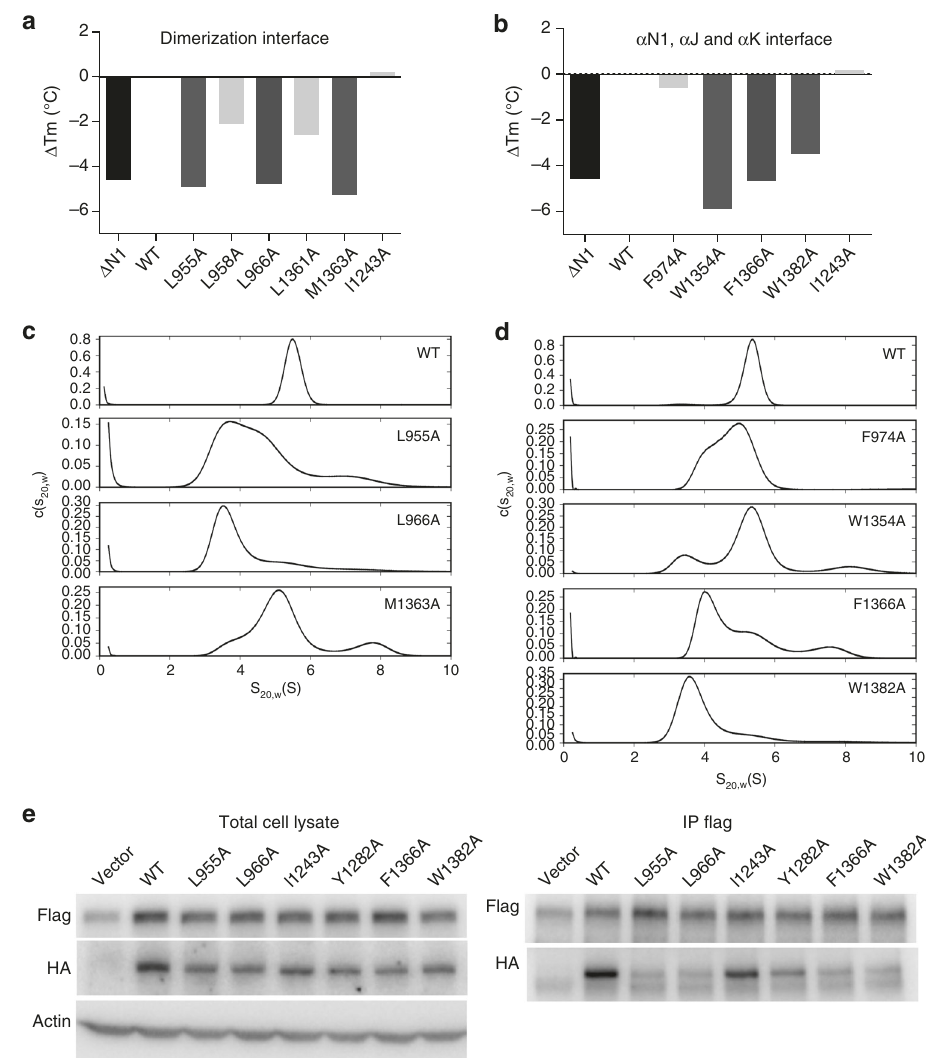
Fig. 4 Two clusters of hydrophobic hot spots mediate SgK223 dimerization. a , b Plots representing the difference in melting temperature between the SgK223- α N1-PsK-Cter (WT), SgK223-PsK-Cter ( Δ N1) and various mutants within the regulatory helices. c , d c ( s 20,w ) distributions for SgK223- α N1-PsK- Cter (WT) and mutants, each analysed at a concentration of 3.0 μ M, where the WT protein is primarily dimeric. e Co-immunoprecipitation of Flag-tagged version of SgK223 FL WT with HA-tagged SgK223 FL WT or mutant proteins in HEK293 cells. Lysates were subjected to immunoprecipitation with an anti- FLAG antibody followed by Western blotting with anti-FLAG or anti-HA antibodies as indicated. Total cell lysates were also blotted with these antibodies, as well as for actin as a loading control. The data are representative of three independent experiments. See also Supplementary Figs. 3 and